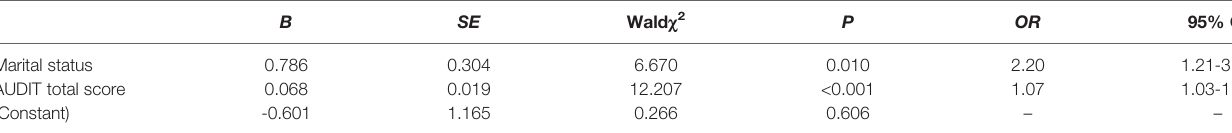
TABLE 2 | Risk factors generated by logistic regression analysis with depression as dependent